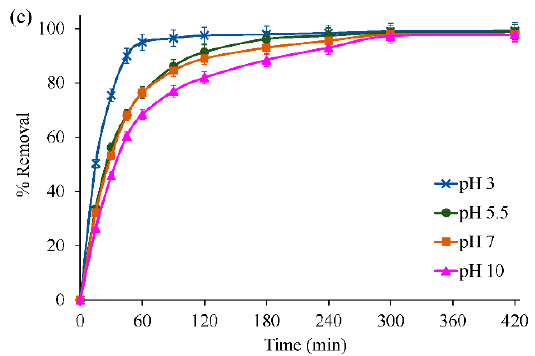
Figure 5. E ff ects of the ( a ) MCC dosage, ( b ) initial dye concentration, and ( c ) pH of solution on the RR120 dye removal over the MCC.